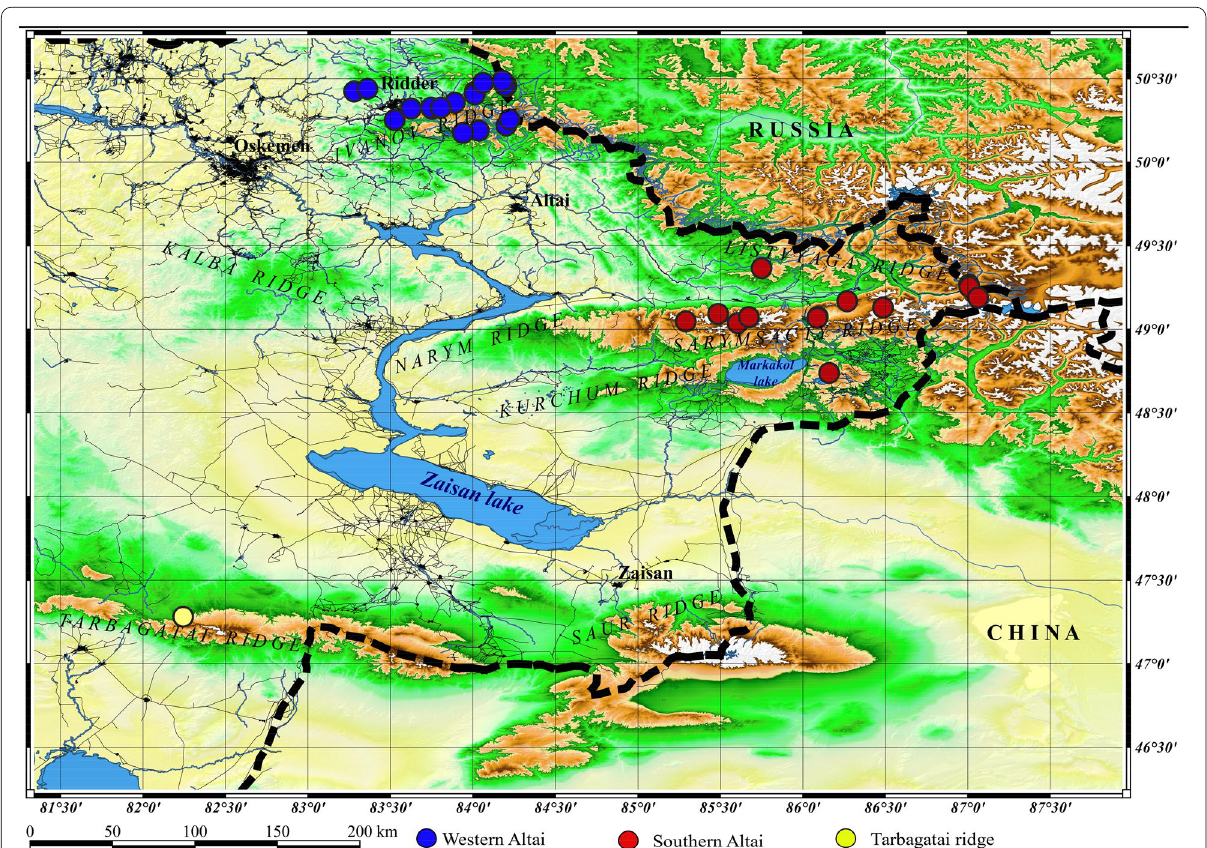
Fig. 1 Scheme map of the distribution of the R. rosea in East Kazakhstan (Scheme map was obtained by